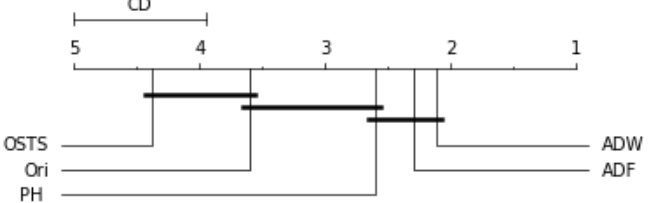
Figure 8. Comparison of the RMSE values obtained by segmentation techniques for LSTM predictor according to the Nemenyi test. Groups that are not significantly different ( α = 0.05 and CD = 1.04) are connected.